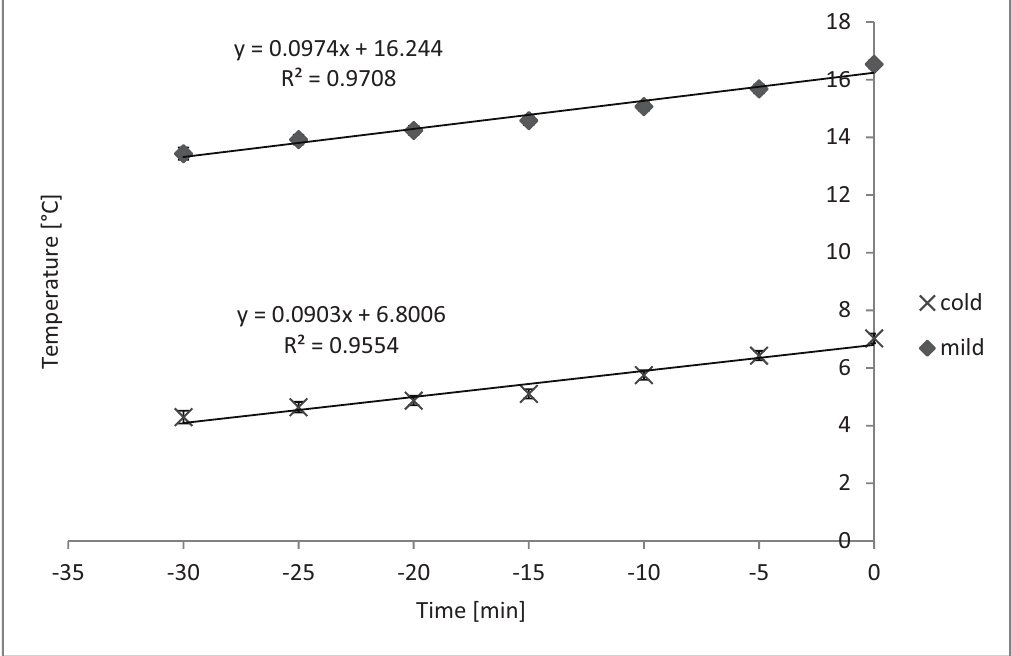
Figure 1. Overall linear time effect on average internal trailer temperature while loading during cold and mild weather ( P < 0.01 and P < 0.01, respectively). Cold SEb = 0.06, n = 33 trailers; Mild SEb = 0.10, n = 21 trailers. Although slopes differed from zero, they did not differ between cold and mild seasons/temperatures ( P =